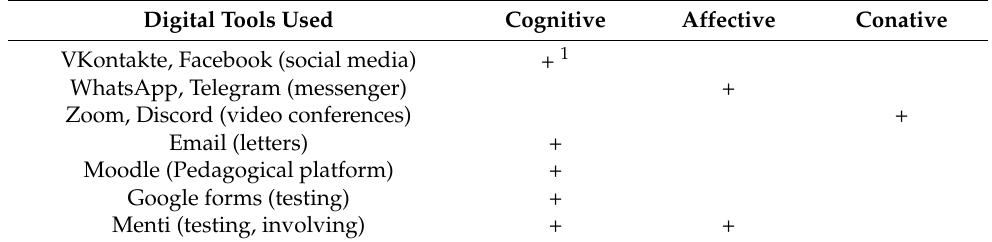
Table 3. Simplified grid of knowledge creation through three components of intellectual